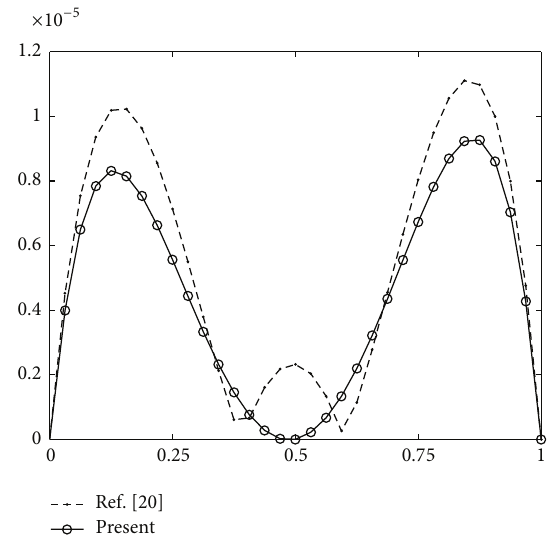
Figure 16: Absolute error distribution at ℎ = 1/32 , 𝜏 = 0.1 , 𝛽 = 1 , 𝛼 = 2 , 𝑝 = 8 , and 𝑡 = 10